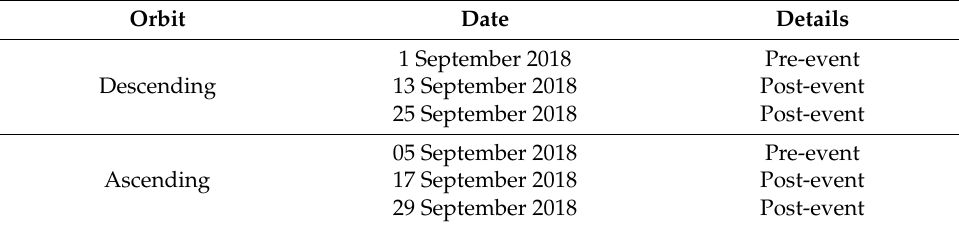
Table 2. Dates of acquisition of Sentinel-1 data for both descending and ascending orbits.